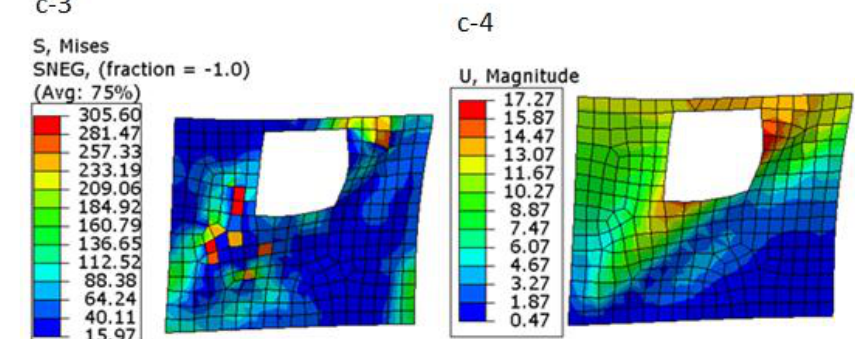
Figure 13. Von Mises stress and displacement for concrete part (c-3) stress and (c-4) displacement.